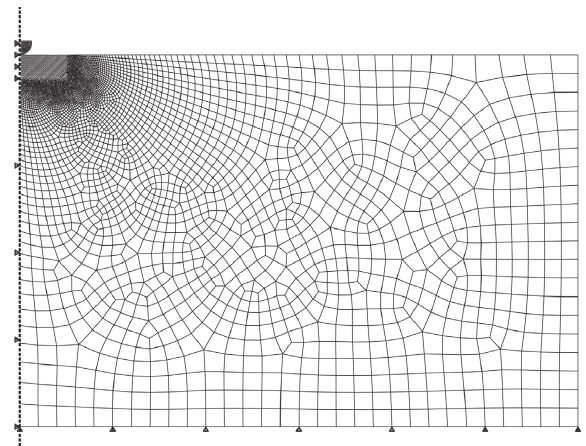
Figure 1: Geometry, mesh, and boundary conditions of the finite element